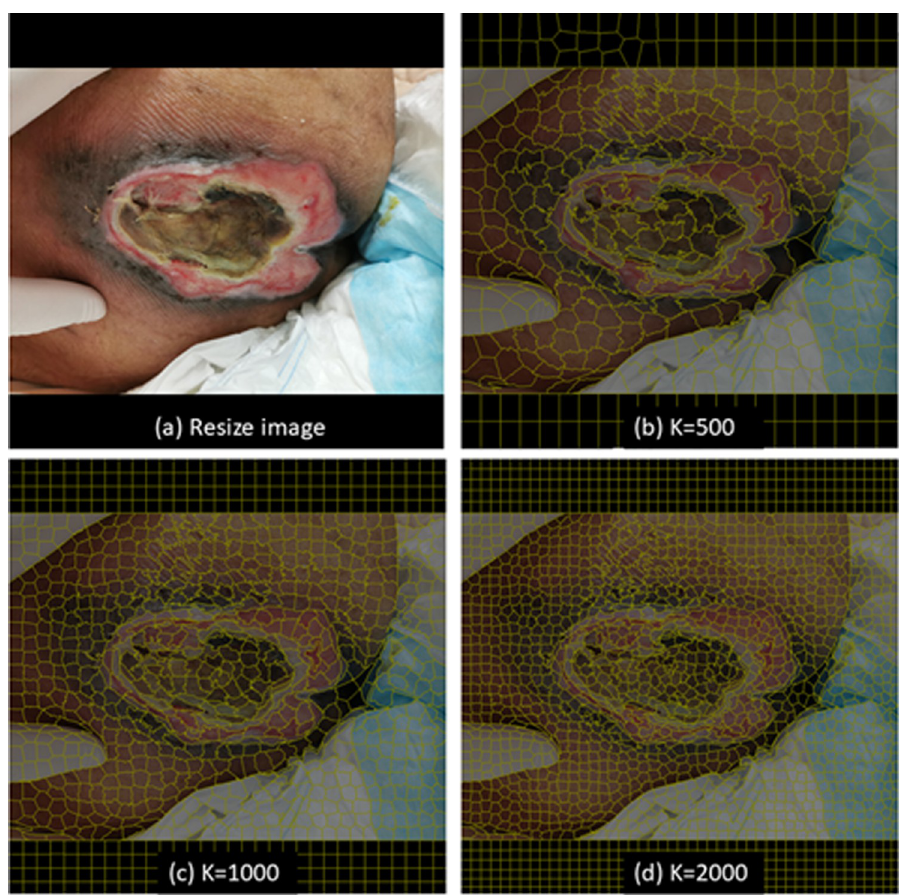
Fig 2. Different number of superpixels (K). (a) Resize image. (b) K = 500. (c) K = 1000. (d) K = 2000.